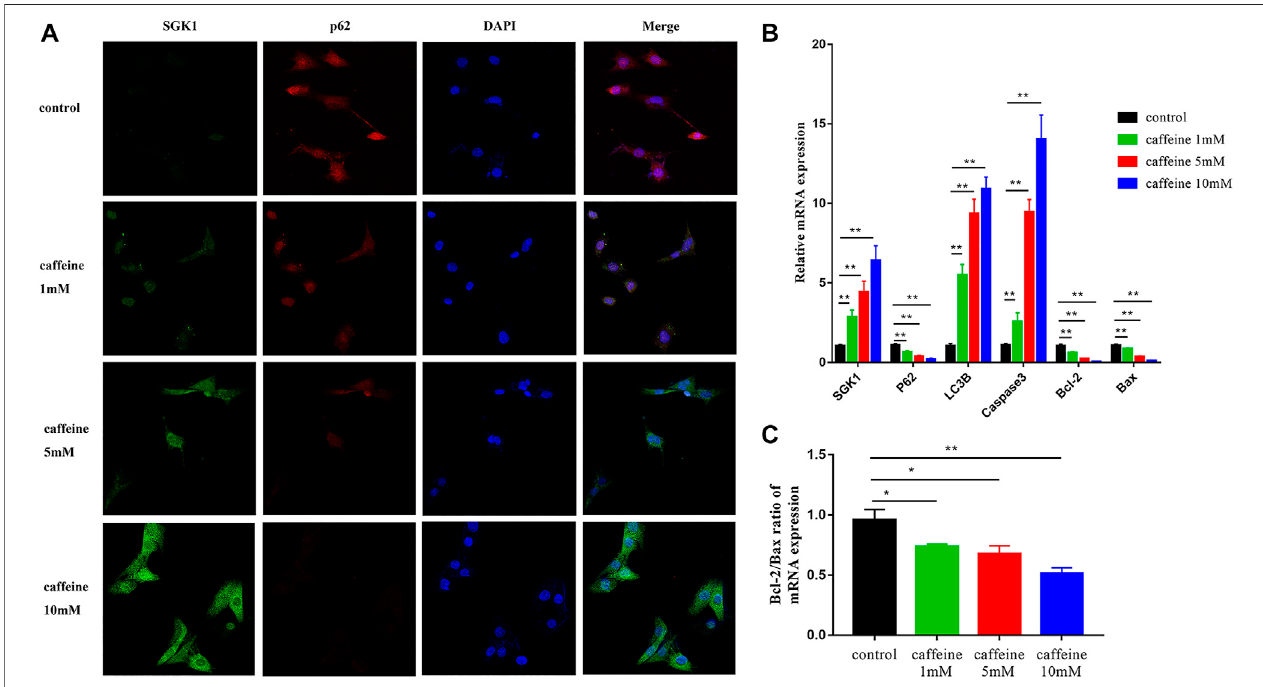
FIGURE 4 | Caffeine affected the expression of SGK1, autophagy, and apoptosis-related genes. (A) Immuno fl uorescence of p62 (red) and SGK1 (green) in HEI- OC1 cells after 24 h of caffeine treatment with different concentrations (0, 1, 5, 10 mM). DAPI (blue) was used to stain the nuclei. Scale bar: 100 μ m. (B) qRT-PCR was used to analyze the mRNA expression of SGK1, p62, LC3B, and Caspase3 in HEI-OC1 cell lines after 24 h caffeine treatment with different concentrations (0, 1, 5, 10 mM), and GAPDH was used as the internal control. Experiments were repeated three times, and data are shown as the means ± SD, **p < 0.01 . (C) Bcl-2/Bax ratio of mRNA expression in HEI-OC1 cells. Data are shown as means ± SD, **p < 0.01 .